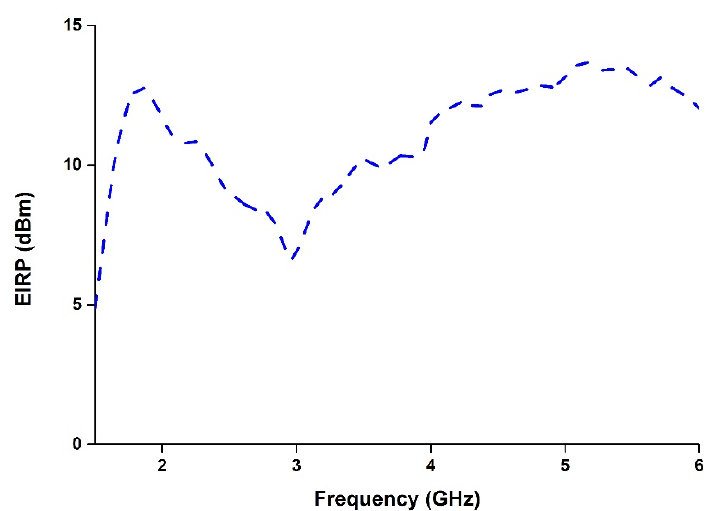
Figure 11. Equivalent isotropic radiated power (EIRP) of the proposed